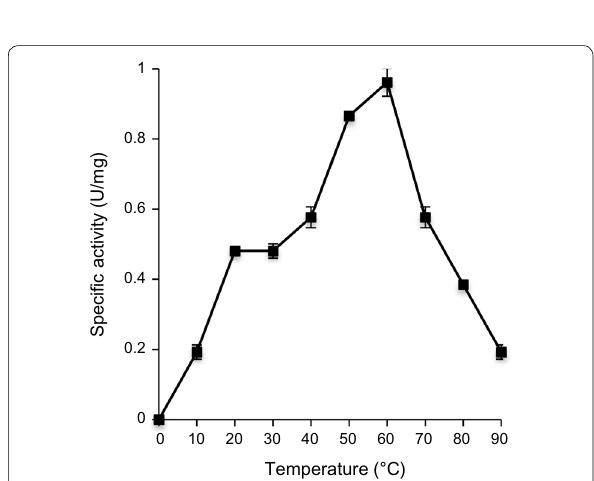
Fig. 7 Optimum temperature for lignin peroxidase with n -propanol as substrate. The experiment was done in duplicate and the values are expressed as mean ±